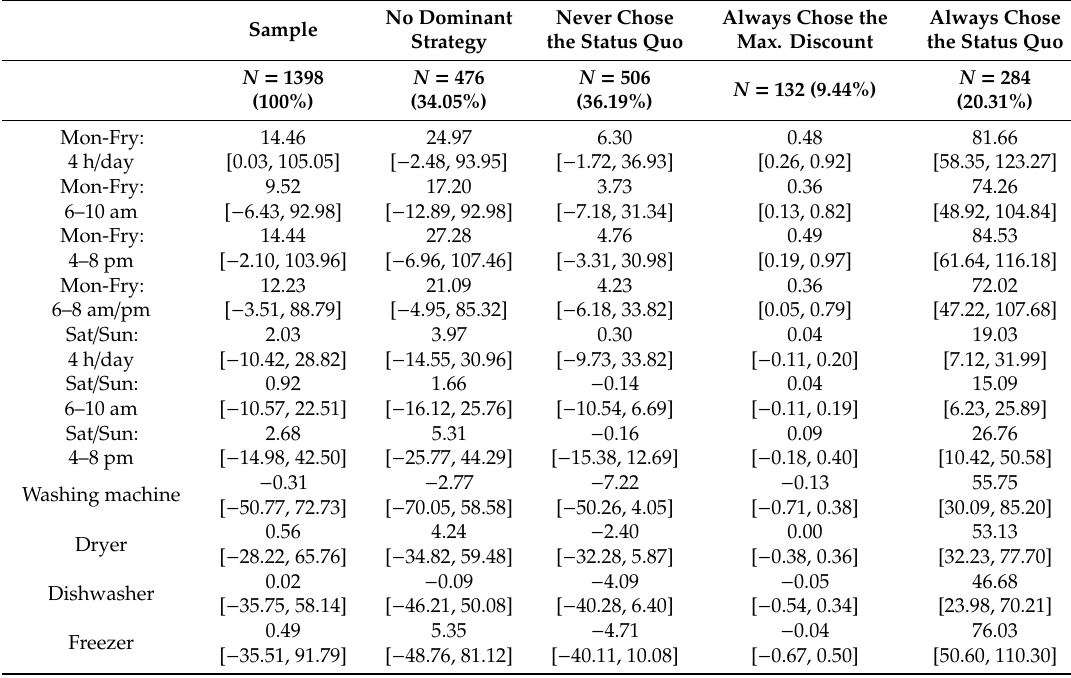
Table 6. Median of marginal conditional WTA in € (in brackets: [5%-quantile, 95%-quantile]).